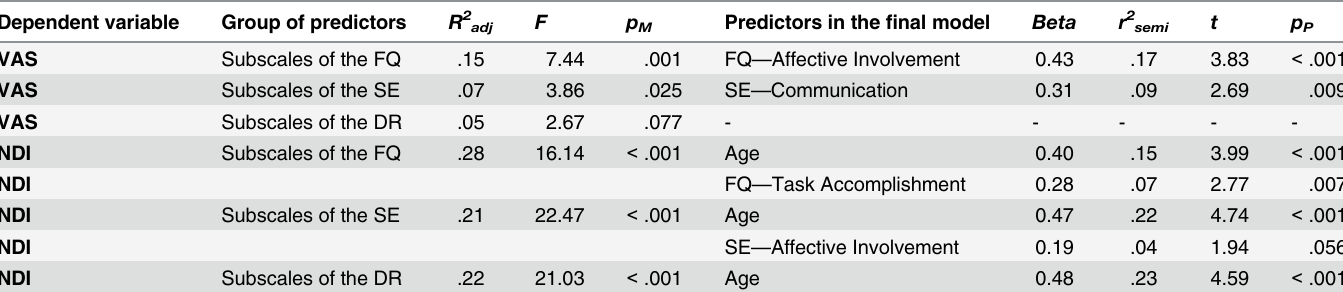
Table 2. Multiple hierarchical-stepwise regression models with VAS and NDI as dependent variables and family functioning as predictors. Dependent variable